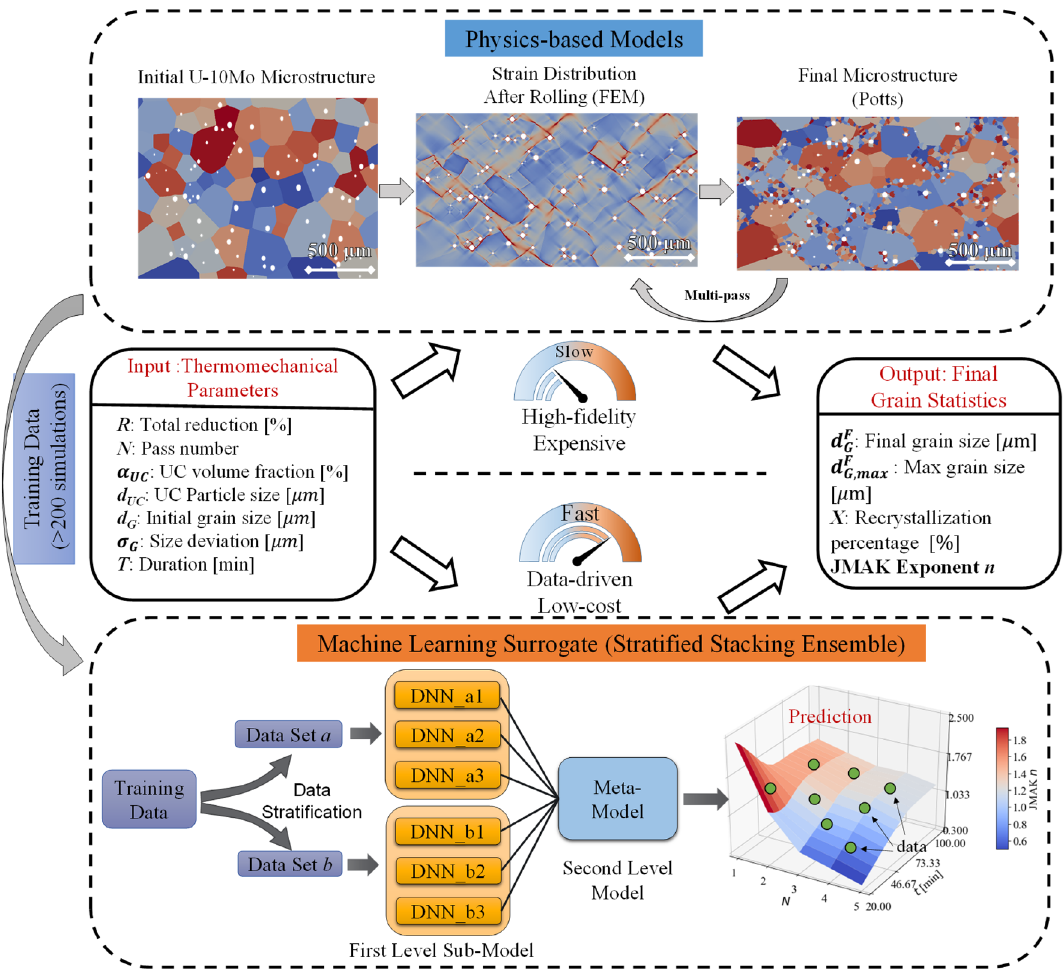
Figure 1. Illustration of the proposed strategy for combining physics-based simulations and a data-driven surrogate model for sensitivity analysis and fast U-10Mo microstructure prediction and eters constant, the cost of modeling U-10Mo hot rolling and annealing process can be reduced significantly. The sensitivity score s i , as defined in Eq. (7), is calculated for each input variable for accessing the global influence of the processing conditions and initial microstructures. Pareto plots ranking the parameters that most strongly affect the final microstructure statistics are shown in Fig. 3. In the charts, the vertical, left-side axes show scaled sensitivity scores, with the sum of s i equal to 1. The bars in the plot represent the normalized sensitivity scores for the input parameters, ranked in descending order from left to right. The right-side, vertical axes of each chart shows the cumulative percentage of the sensitivity scores. The input parameters selected in the plots contribute 99% of the output parameter variations. For the final grain size d F G , the annealing time and rolling reduction percentage are the most dominant fac- tors in determining the final grain size. Recrystallization can happen in local regions induced by concentrated strain for short annealing times. Over a long annealing time, grain coarsening becomes more dominant as grain recrystallization increases. Those effects make the annealing time an important factor in controlling the final average U-10Mo grain size. The hot rolling reduction percentage is another critical factor that determines the final average grain size for either single- or multi-pass hot rolling and annealing. For the maximum grain size, the reduction percentage, number of passes, initial grain size, and standard deviation are the four most influential factors, accounting for over 99% of the variation. In the current simulations, the maximum annealing time is 120 min. With this range, the grain coarsening effect is not dominant, thus, the contribution of annealing time to the maximum grain size is trivial. Further increasing annealing time, the abnormal grain growth will start and it would become the important mechanism that determines the final maximum grain size. Regarding recrystallization kinetics, the dominant input parameters that affect the recrystallization and the JMAK exponent are quite different. For the recrystallization percentage, hot rolling reductions create dislocations that drive the grain refinement process. Annealing subsequently releases those dislocation sources, which can negatively or positively contribute to the final grain size, depending on the duration of the heat treatment. Along with the number of processing passes, hot rolling and annealing largely determine the final extent of U-10Mo grain recrystallization. However, for the JMAK exponent n , the variation can be explained by the number of